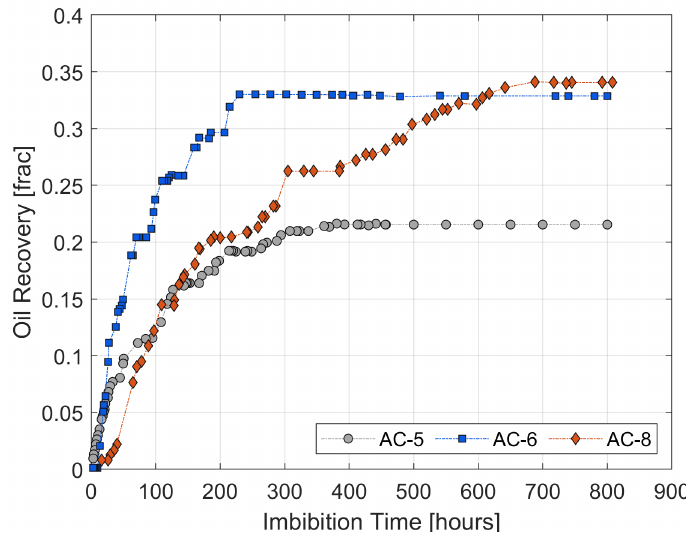
Figure 2. Spontaneous oil imbibition characteristics for core plugs exposed to formation water (AC-5) and carbonated formation water (AC-6, AC-8).